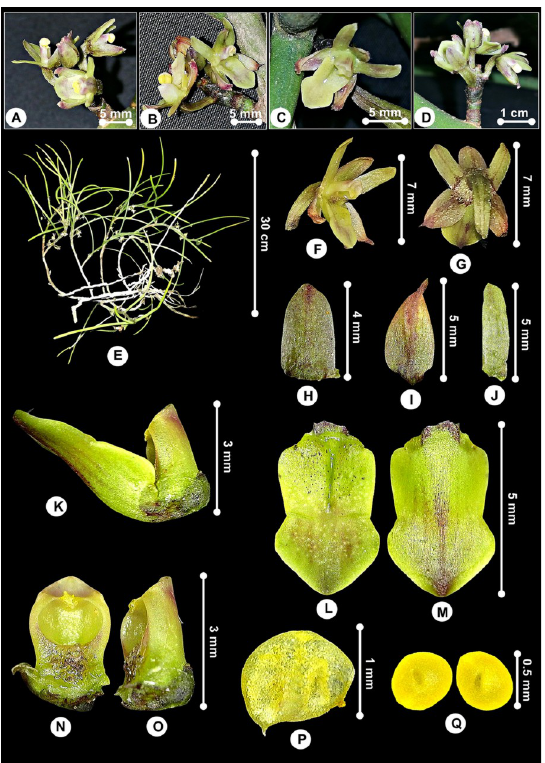
Fig 6. Luisia brachystachys . A, B. Flowers from top and lateral views. C. Flower’s front view. D. Inflorescence. E. Plant. F. Flower’s lateral view. G. Flower’s dorsal view. H. Dorsal sepal. I. Lateral sepal. J. Petal. K. Labellum and Gymnostemium. L. Labellum’s abaxial view. M. Labellum’s adaxial view. N. Gymnostemium’s front view. O. Gymnostemium’s lateral view, P. Anther-cap, Q.